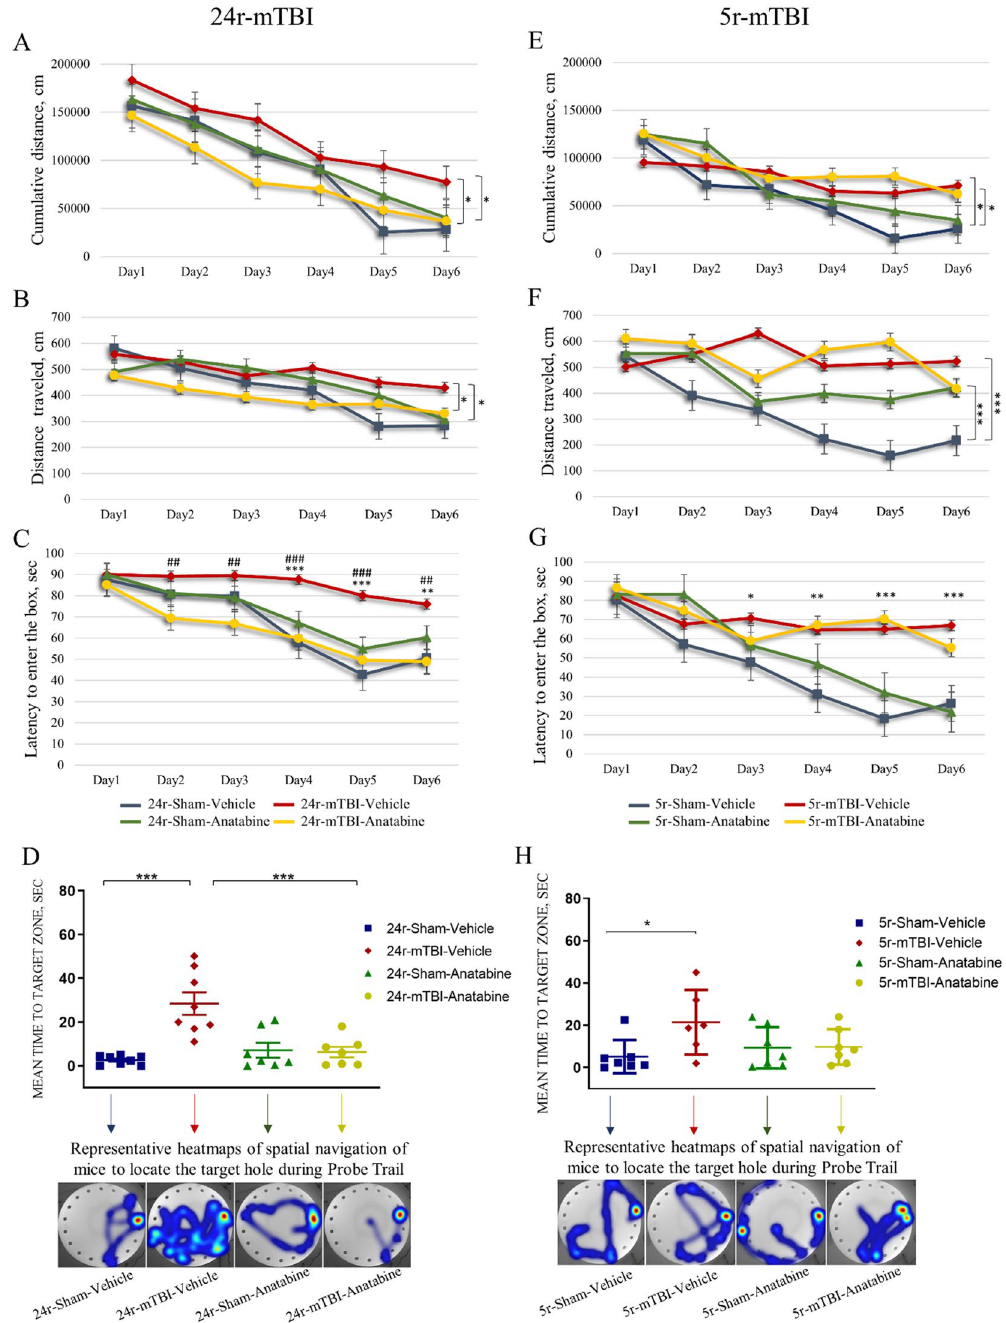
Figure 4. Evaluation of learning and memory in 24r-mTBI and 5r-mTBI mice. Anatabine treatment improved spatial memory deficits in the 24r-mTBI but not 5r-mTBI mice. In the 24r-mTBI cohort, 24r-mTBI-vehicle mice exhibited longer cumulative distance (( A ); p < 0.05), distance traveled (( B ); p < 0.05), and latency to enter the box on days 4–6 ( C ) compared to 24r-sham vehicle during the acquisition trial. Similarly, in the 5r-mTBI cohort, 5r-mTBI-vehicle mice exhibited longer cumulative distance (( E ); p < 0.05), distance traveled (( F ); p < 0.001), and latency to enter the box on days 3–6 ( G ) compared to 5r-sham vehicle. 24r-mTBI-anatabine mice showed a decrease in cumulative distance (( A ); p < 0.05), distance traveled (( B ); p < 0.05) and latency ( C ) compared to 24r-mTBI- vehicle mice. Anatabine did not attenuate memory deficits in the 5r-mTBI-anatabine group during the acquisition trial. During the probe trial, 24r-mTBI increased mean time to target zone compared to sham-vehicle mice (( D ); p < 0.001), which was decreased in the 24r-mTBI-anatabine mice vs 24r-mTBI (( D ); p < 0.001). In the 5r-mTBI group, 5r-mTBI-vehicle mice had an increase in mean time compared to 5r-sham- vehicle (( H ); p < 0.05) but no anatabine induced decrease was detected in the 5r-mTBI-anatabine mice, however the trend is present. Latency in 5r-mTBI-anatabine mice was not significantly different from the 5r-sham-vehicle mice (p = 0.082). Statistical significance for the cumulative distance and distance traveled were analyzed using MANOVA; the mean time to target hole was analyzed using one-way